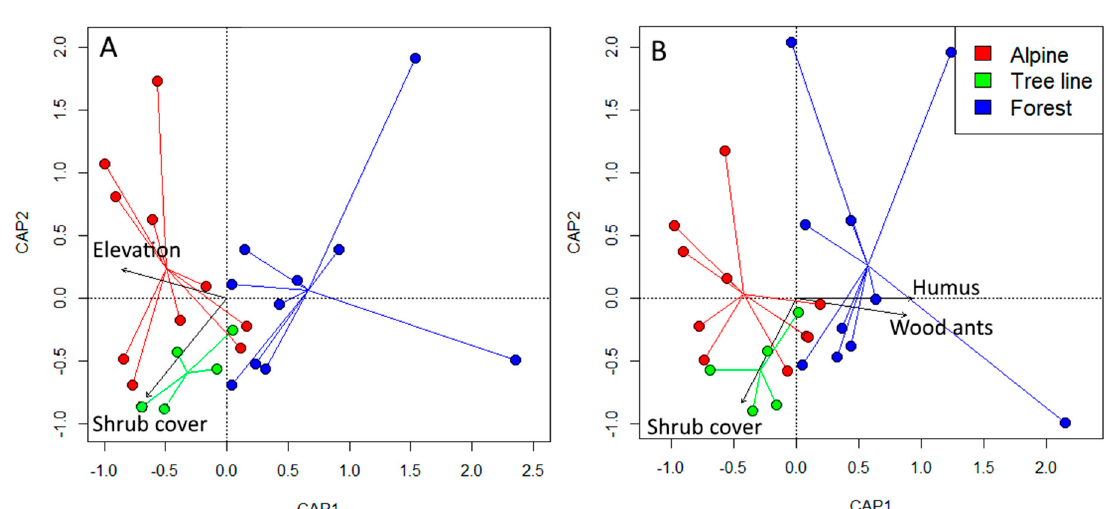
Figure 4. Ordination plots from the capscale routine. ( A ) The influence of the most important explanatory variables (viz. dwarf shrub cover and elevation) upon the full community of ants. ( B ) Ordination showing the species composition of subdominant ant assemblage and the most important explanatory variables (viz. wood ant abundance, dwarf shrub cover and soil humus indicator value of the vegetation). The mound-building dominant wood ant species were here excluded from the ant community matrix and their abundance score served as additional explanatory variable for the remaining subordinate fraction of the ant community. Ant communities from alpine grassland and forest sites cluster apart from another. Those from tree line sites cluster more with the alpine sites and display a reduced dispersion. Spider web centers represent the weighted centroids of community samples for each habitat type.